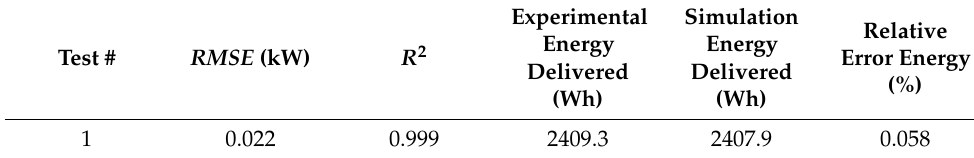
Table 6. Battery Parameter Identification Power and Energy Metrics.